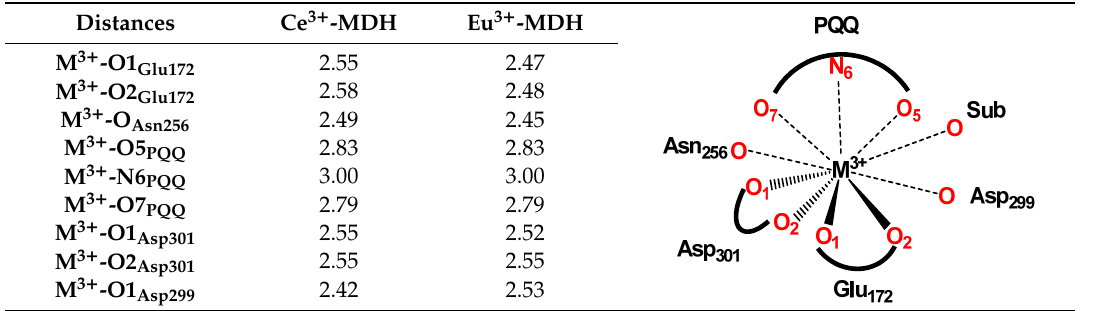
Table 2. Comparison between bond distance in first coordination sphere of M 3 + -MDH (M 3 + = Ce, Eu)